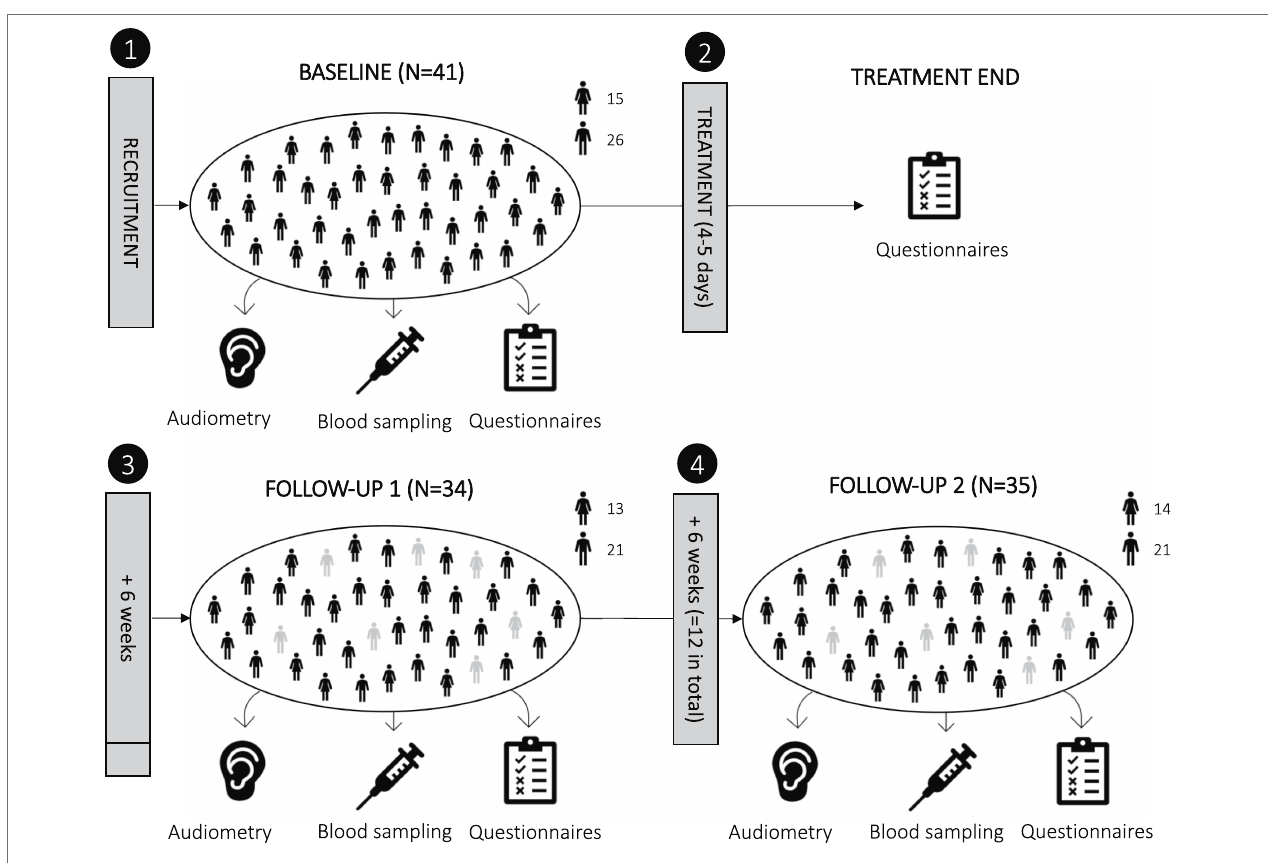
FIGURE 1 | Overview of study design. The study included four scheduled measurement sessions: (1) baseline, (2) directly after treatment (4–5 days later), (3) 6-week follow-up, and (4) 12-week follow-up. Actual follow-ups were performed on average after 7.8 and 13.8 weeks. Dropouts are shown in